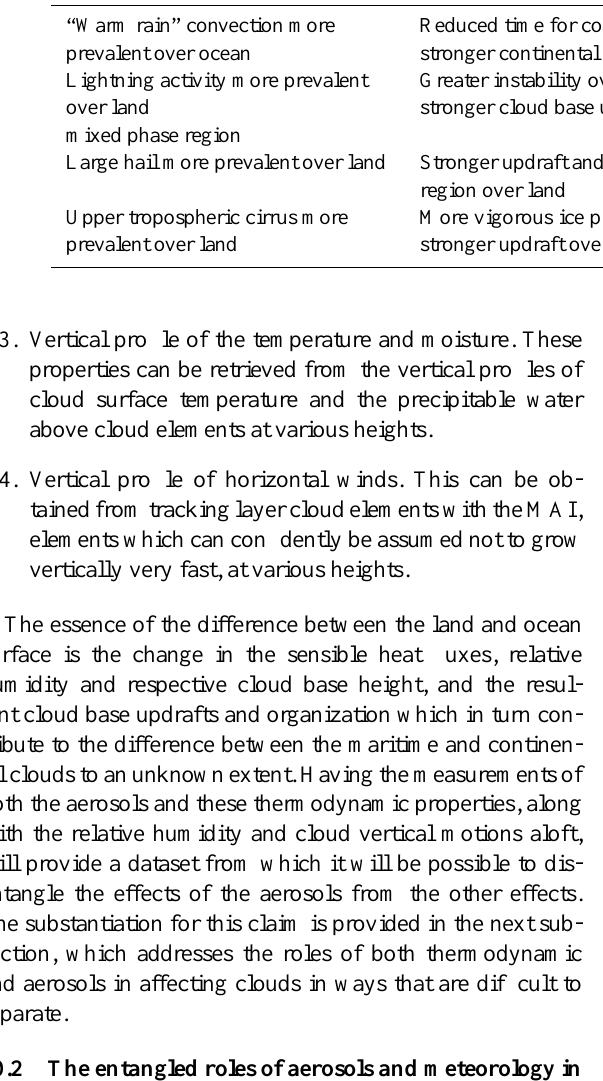
Larger droplets over ocean Enhanced delivery of cloud water to Enhanced delivery of cloud water to mixed phase region Greater numbers of small ice particles nucleated over